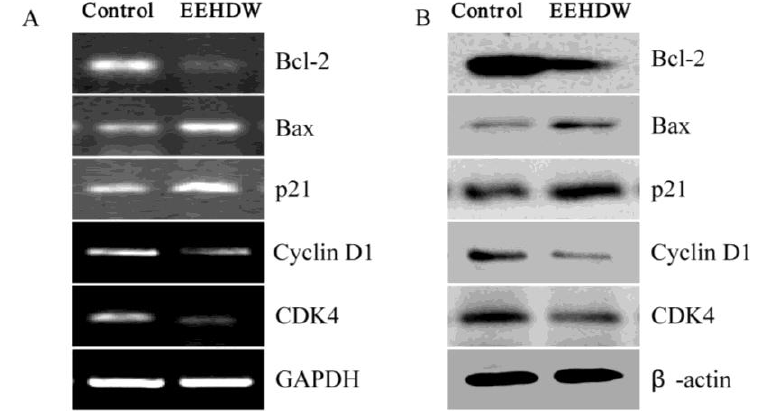
Figure 5. Effect of EEHDW on the expression of Bcl-2, Bax, p21, Cyclin D1 and CDK4 in CRC xenograft mice. ( A , B ) Three tumors were randomly selected from each group and the mRNA or protein expression levels of Bcl-2, Bax, p21, Cyclin D1, CDK4 were determined by RT-PCR ( A ) and Western blot analyses ( B ). GAPDH and β-actin were used as the internal controls for the RT-PCR or Western blotting, respectively. For each tumor sample, Western blot and RT-PCR analyses were was performed in triple. Data shown are representatives. ( C , D ) Densitometric analysis. The data were normalized to the mean mRNA ( C ) or protein ( D ) expression of untreated control (100%). * p < 0.01, versus